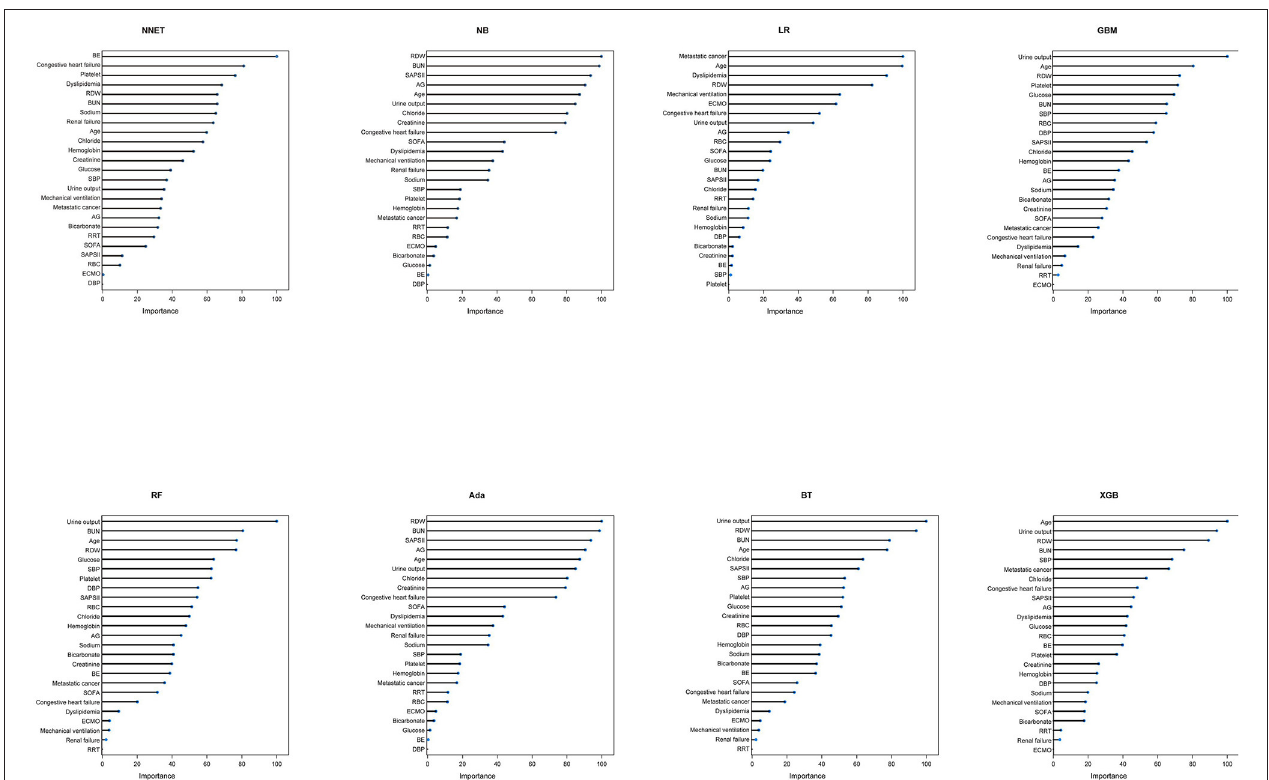
FIGURE 3 | Variable importance in different models. NNET, artificial neural network; NB, naïve bayes; GBM, gradient boosting machine; Ada, adapting boosting; RF, random forest; BT, bagged trees; XGB, eXtreme Gradient Boosting; LR, logistic regression; RDW, red blood cell distribution width; BUN, blood urea nitrogen; SAPS II, Simplified Acute Physiology Score II; AG, anion gap; SOFA, Sequential Organ Failure Assessment; SBP, systolic blood pressure; RRT, renal replacement therapy; RBC, red blood cell; ECMO, extracorporeal membrane oxygenation; BE, base excess; DBP, diastolic blood pressure.